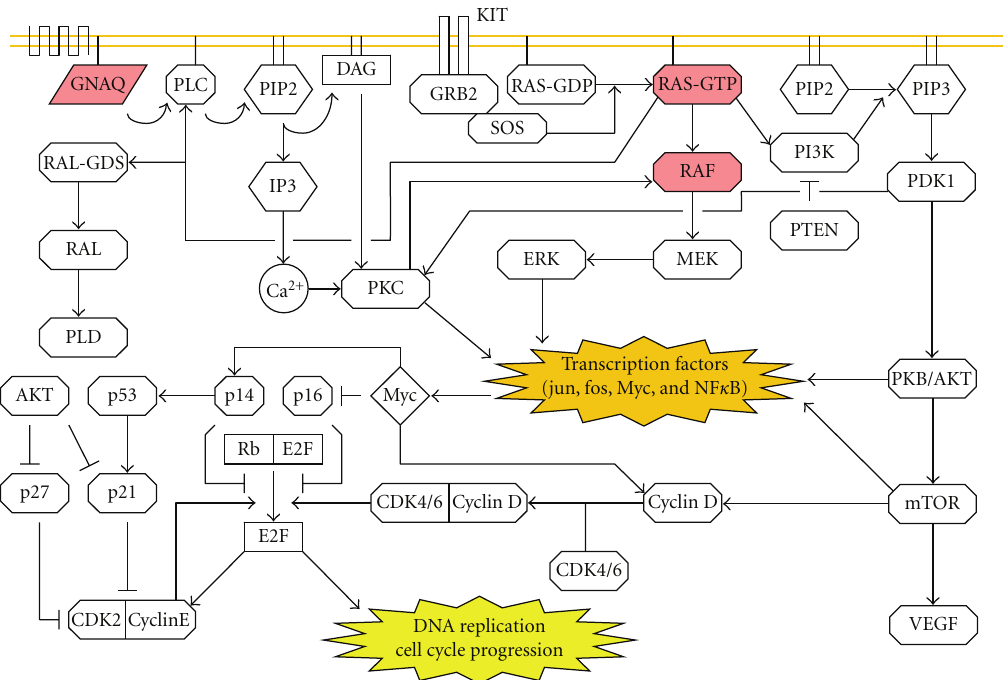
Figure 1: Relative position of RAS, RAF, and GNAQ in intracellular signaling. Mutations in NRAS, HRAS < BRAF, and GNAQ lead to alterations in transcription factor expression (MIT-F and Brn2 not shown). This in turn drives a number of processes like cell cycle progression. The contribution of the transcription factor Myc to cell cycle progression and its relationship to tumor suppressors are shown downstream of the aforementioned